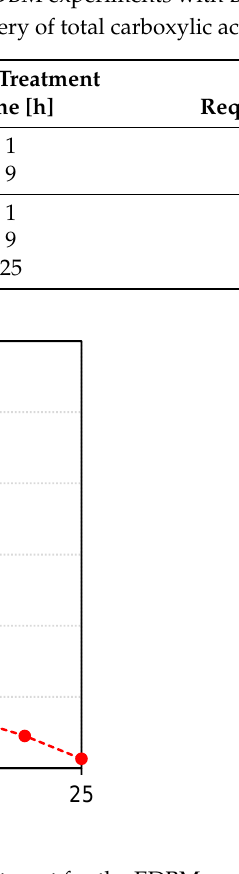
Figure 7. Yields of total acids in the acid compartment for the EDBM experiment with BL permeate ( ● ) and BL model solution ( ● ).